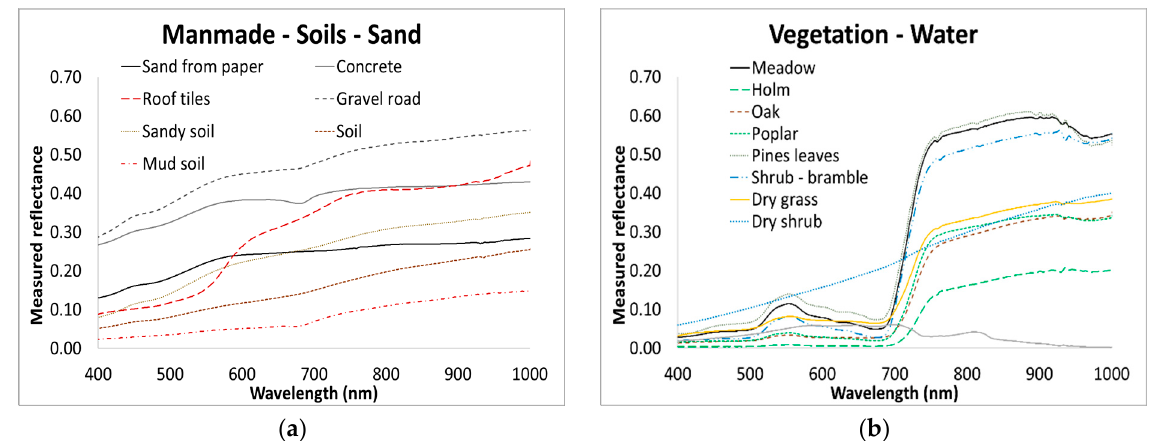
Figure 9. Spectral reflectance measurements of different materials acquired during a field campaign in the Migliarino–San Rossore–Massaciuccoli Regional Park (Italy) using a Fieldspec Spectroradiometer. Reference measurements were performed using a Spectralon tablet. The spectrum of each material was obtained as an average of 10 measurements. The spectra of manmade materials and different type of soil are shown in ( a ). Vegetation and water spectra are shown in ( b ).